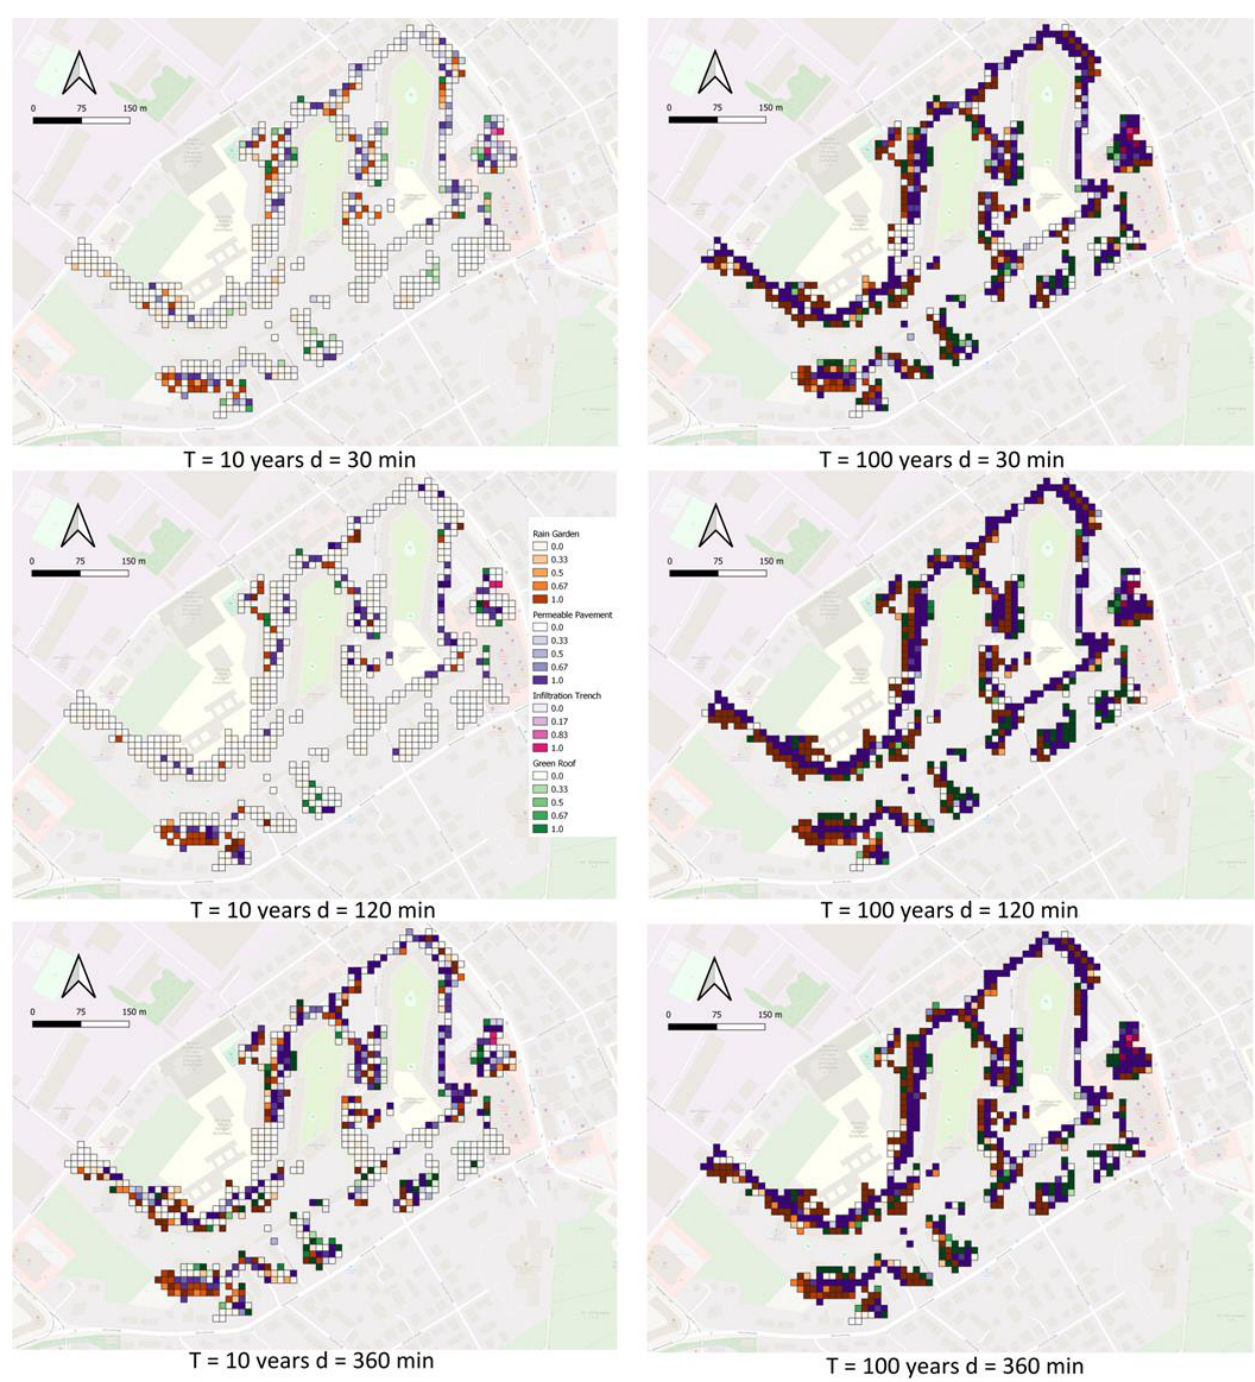
Figure 6. SUDS frequency selection in the Pareto front solutions for events.